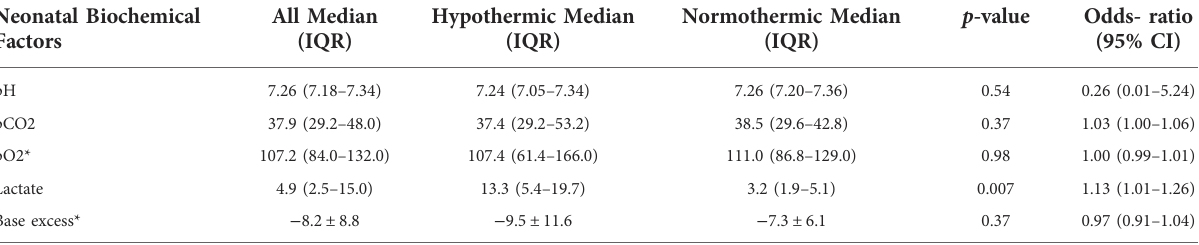
TABLE 5 Neonatal biochemical parameters.